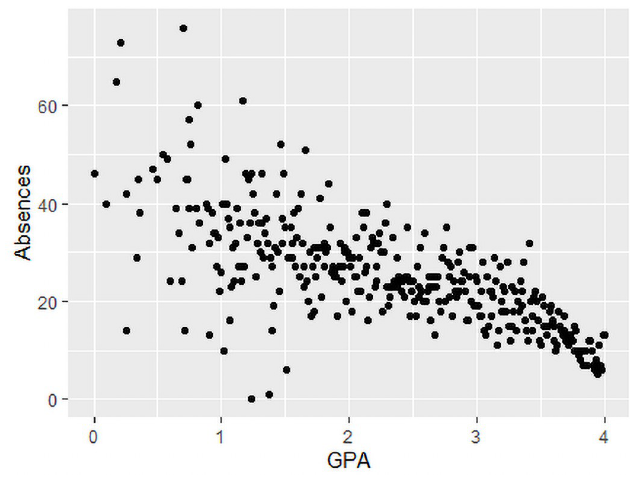
Fig 4. Scatter plot of the average number of absences and the